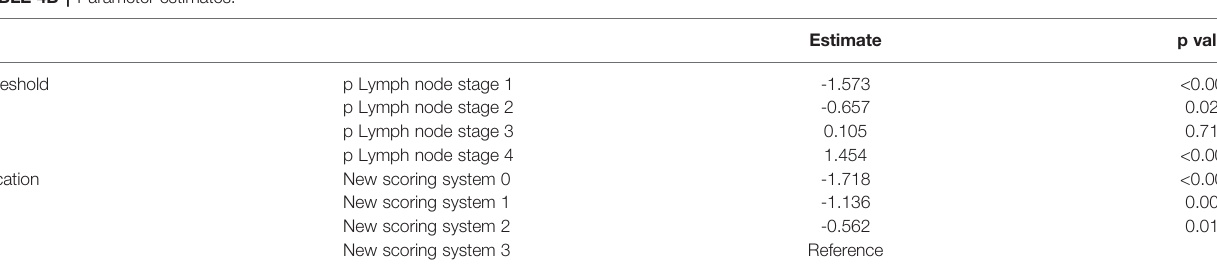
TABLE 4B | Parameter estimates.